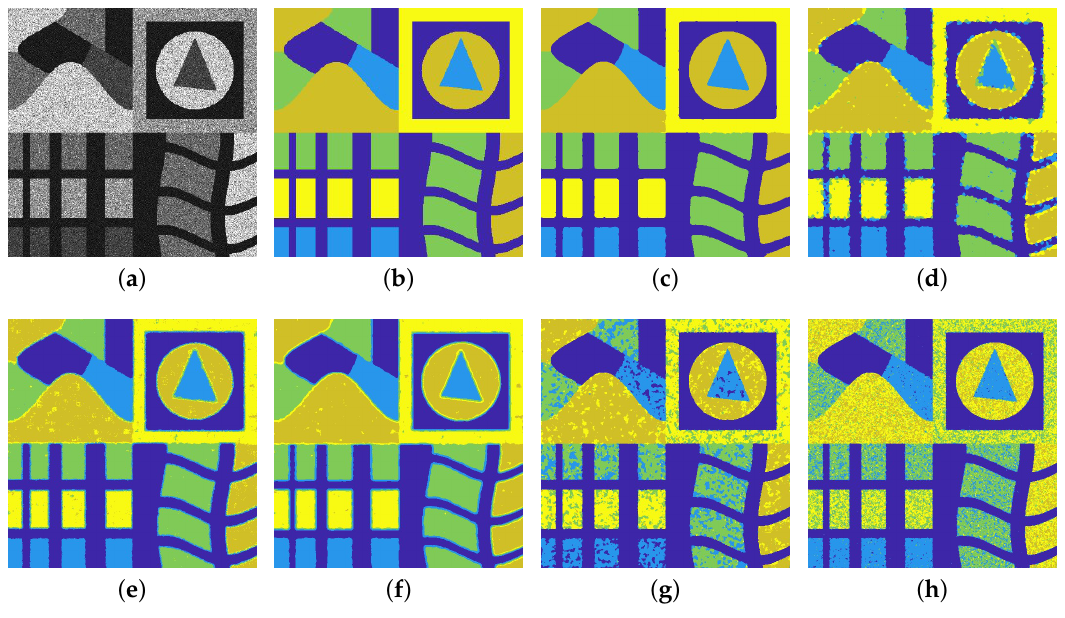
Figure 15. Segmentation results: ( a ) experimental image, ( b ) ground truth, ( c ) proposed, ( d ) FKPFCM [29], ( e ) NSFCM [1], ( f ) ILKFCM [28], ( g ) ALFCM [31], ( h ) CKSFCM [30].